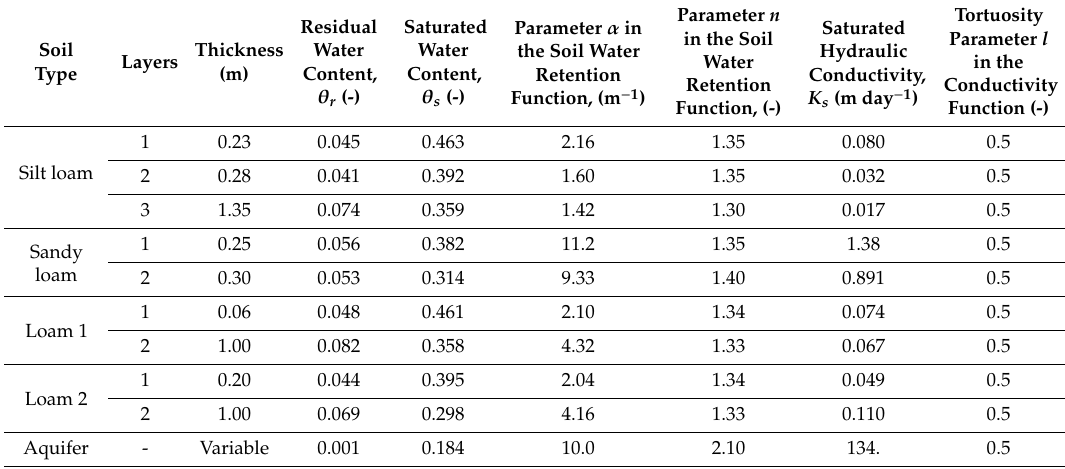
Table 1. Di ff erent types of soil, soil layers, soil hydraulic properties (the van Genuchten–Mualem analytical model parameters) [62] and aquifer properties [30,61].